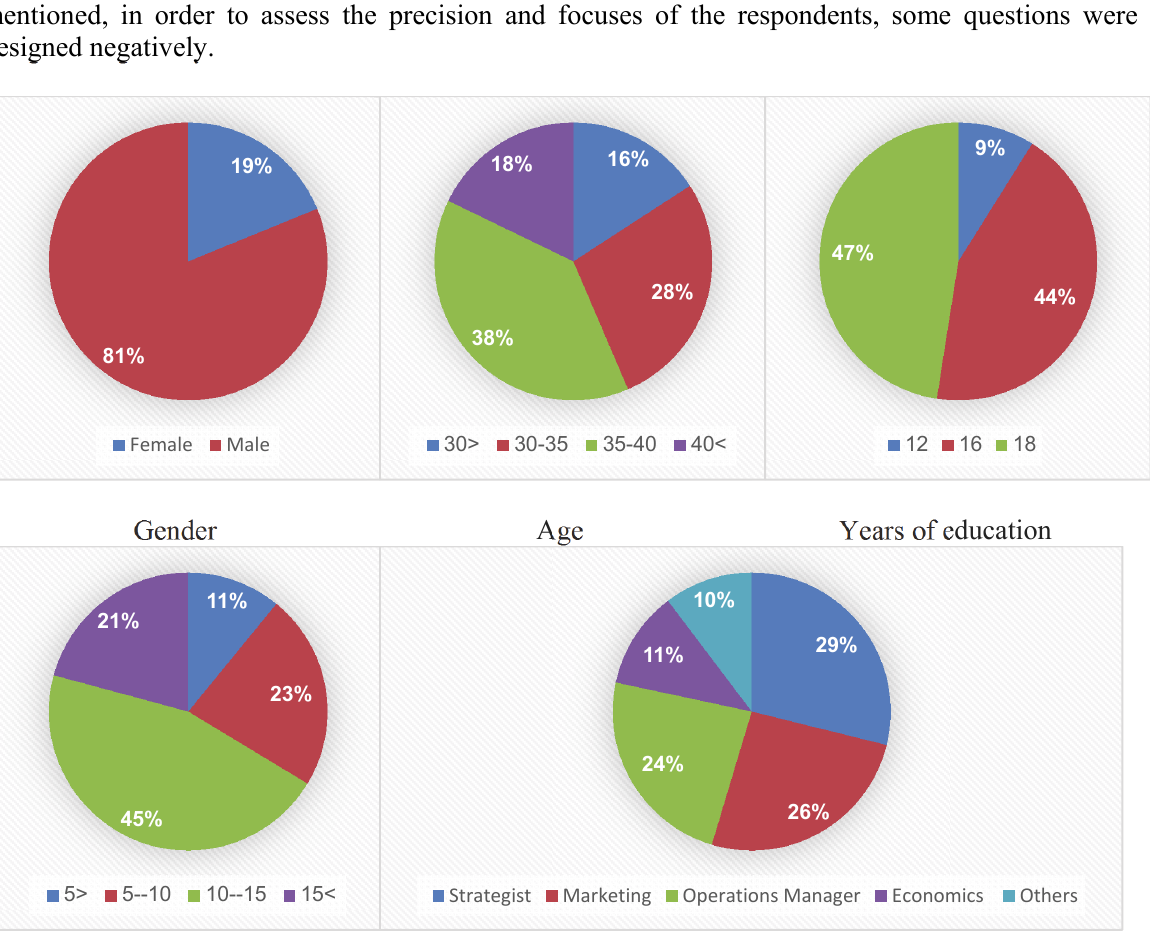
Fig. 2. Personal characteristics of the